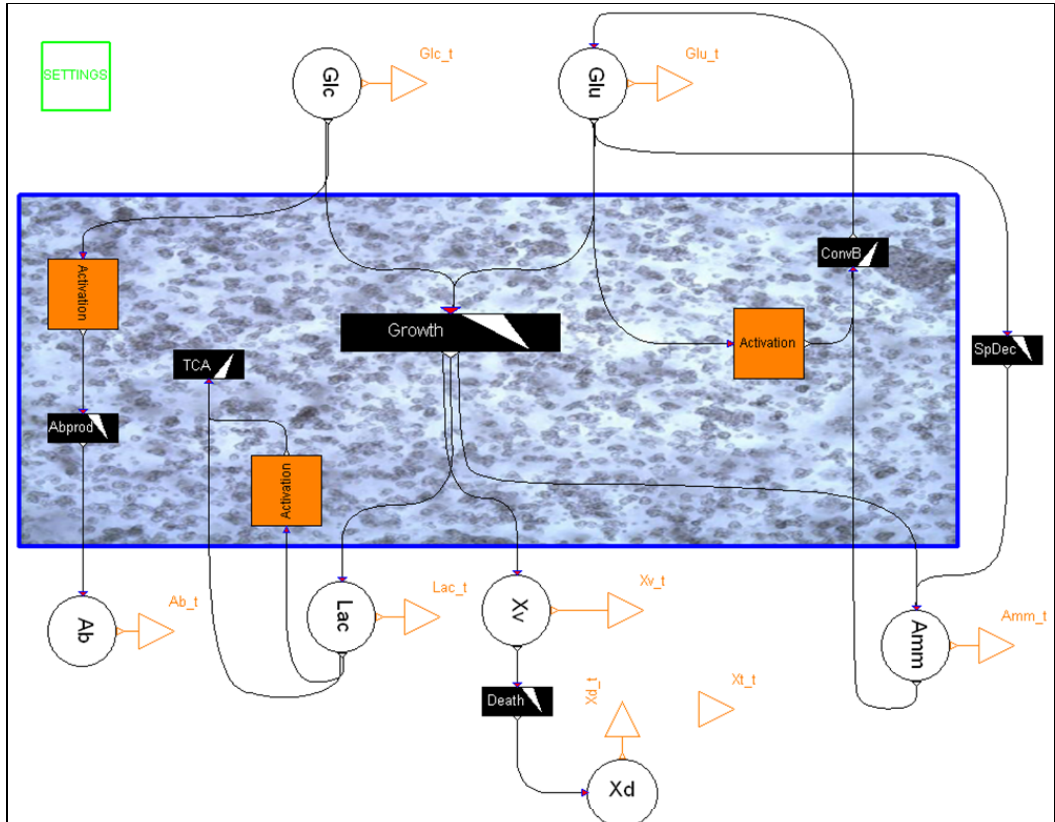
Figure 29: Stochastic Petri Net model of the main CHO-metabolism.